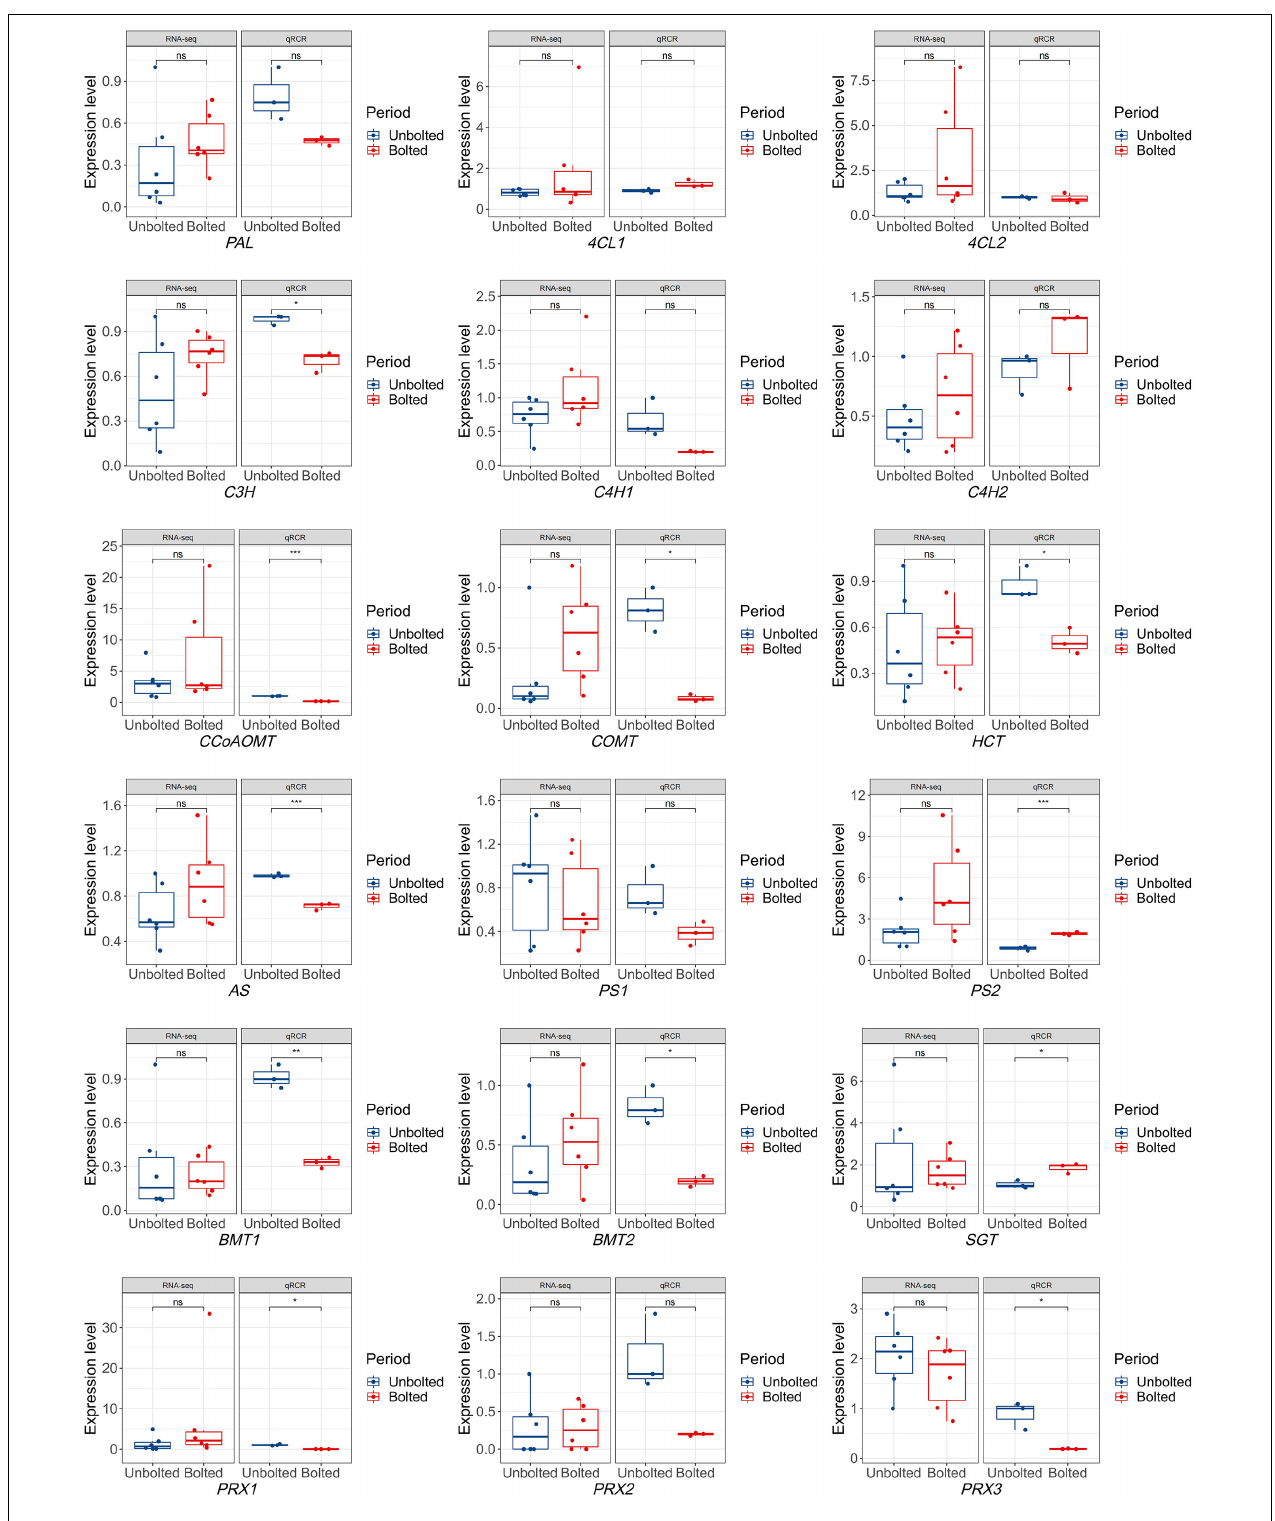
FIGURE 6 | The expression levels of eighteen coumarin biosynthetic genes obtained by RNA-seq and q PCR analysis. The expression level obtained by RNA-seq technology contains 6 biological replicates, while the expression level obtained by qPCR method contains 3 biological replicates. Significant differences in the expression levels of coumarin biosynthesis genes were analyzed in the unbolted and bolted P. praeruptorum . One asterisk indicates significant difference between two periods. Three asterisks indicate extremely significant difference between two periods. “ns” indicates no significance. *denote there is significant difference between two groups (0.01 < P < 0.05). **denote there is extremely significant difference between two groups ( P < 0.01). ***denote there is extremely significant difference between two groups ( P < 0.001). Frontiers in Plant Science |